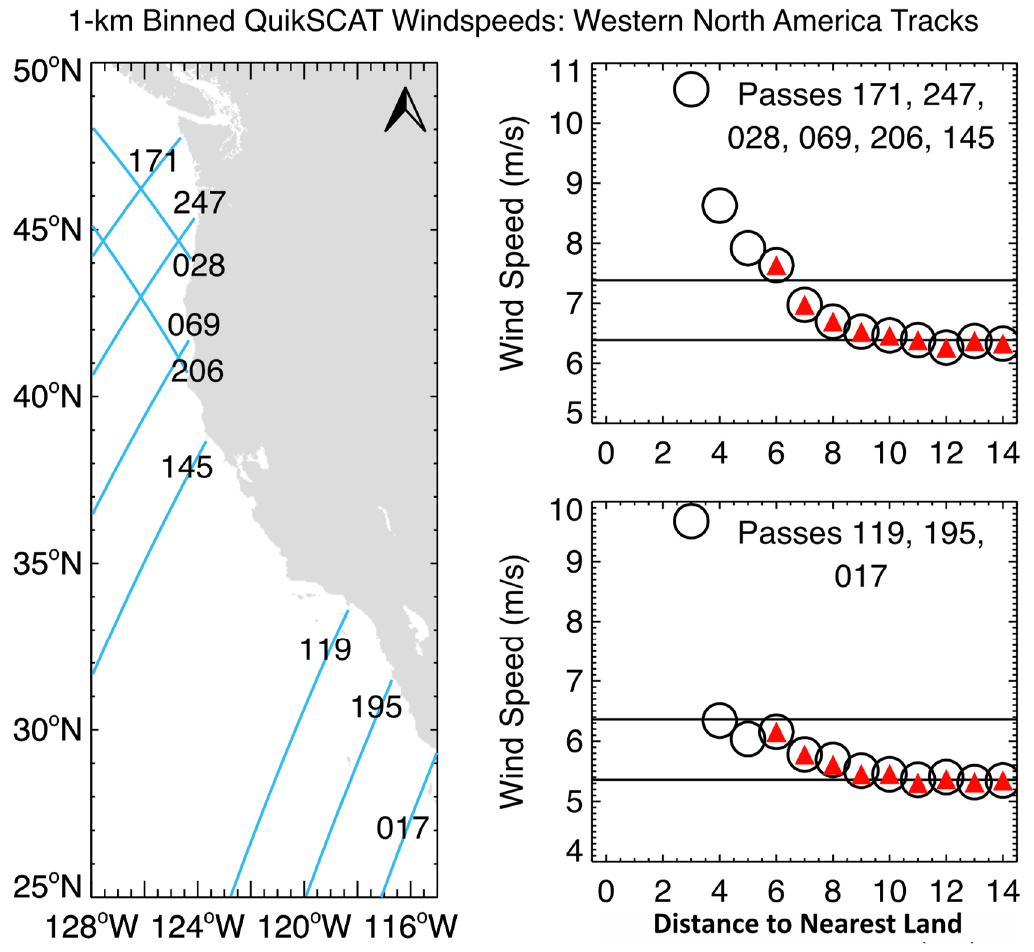
Figure 9. As in Figure 8, scatterometer wind speeds from L2B retrievals within the nearest 7 × 13 km bin to the coast, averaged into 1-km bins based on the distance from the L2B vector wind retrieval to the nearest land along each altimeter track (similar to Figure 7). Here we composite all retrievals during all seasons from multiple tracks along two regions of the U.S. West Coast: the more energetic region off northern California, Oregon and Washington; and the calmer region within the Southern California Bight. Black circles, red triangles and horizontal lines are as in Figure